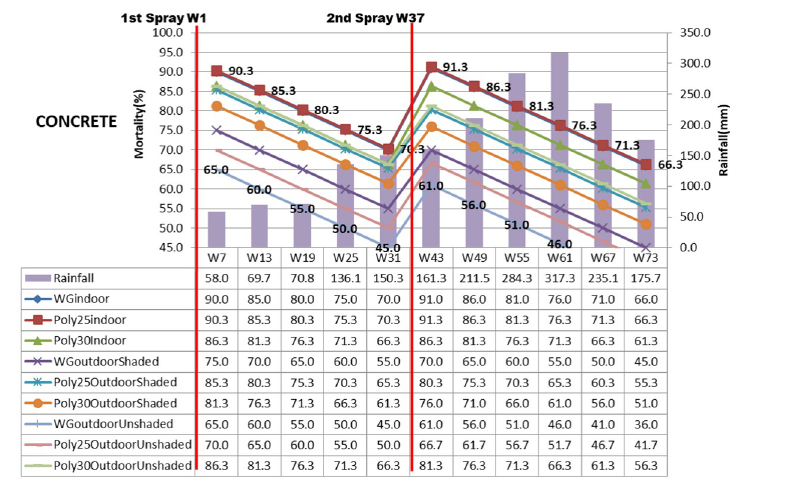
Fig 5. Mortality rate (%) based on location, insecticide, concrete wall and